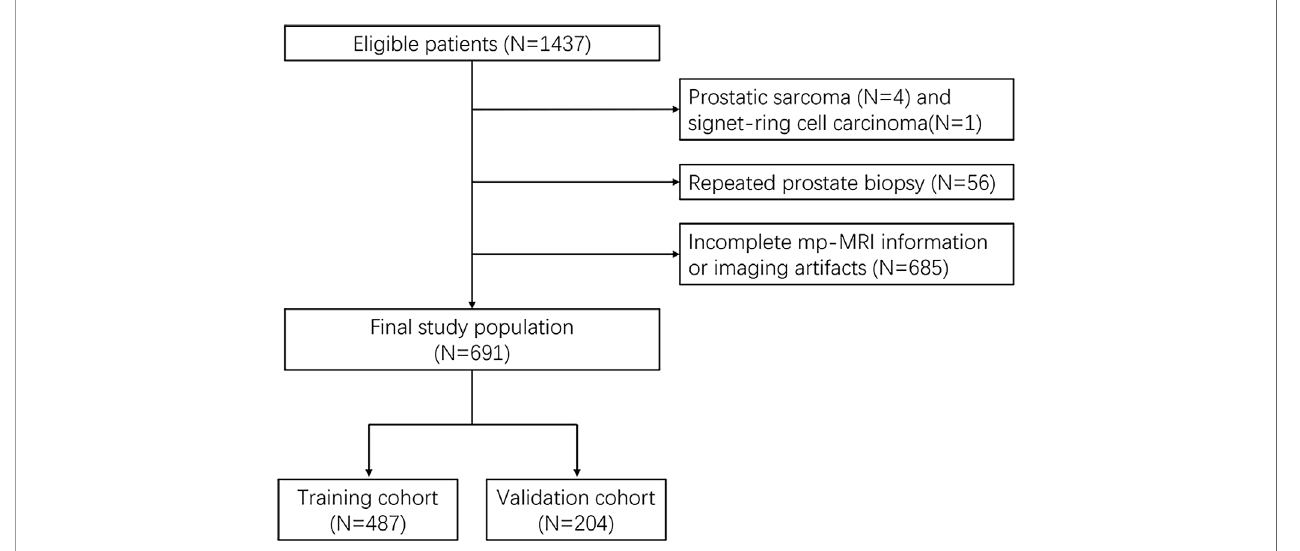
FIGURE 1 | Flow chart of patient